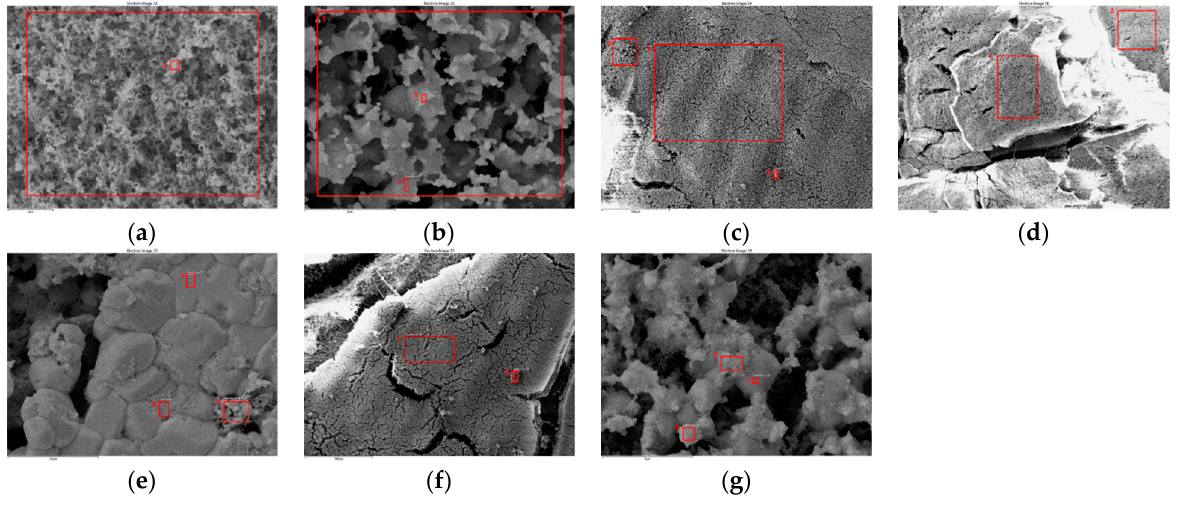
Figure A1. TPM samples with scanned regions ( a ) WP; ( b ) 50CCP; ( c ) CCP; ( d ) CCP1KAO (1); ( e ) CCP1KAO (2); ( f ) CCP2KAO (1); ( g ) CCP2KAO (2).